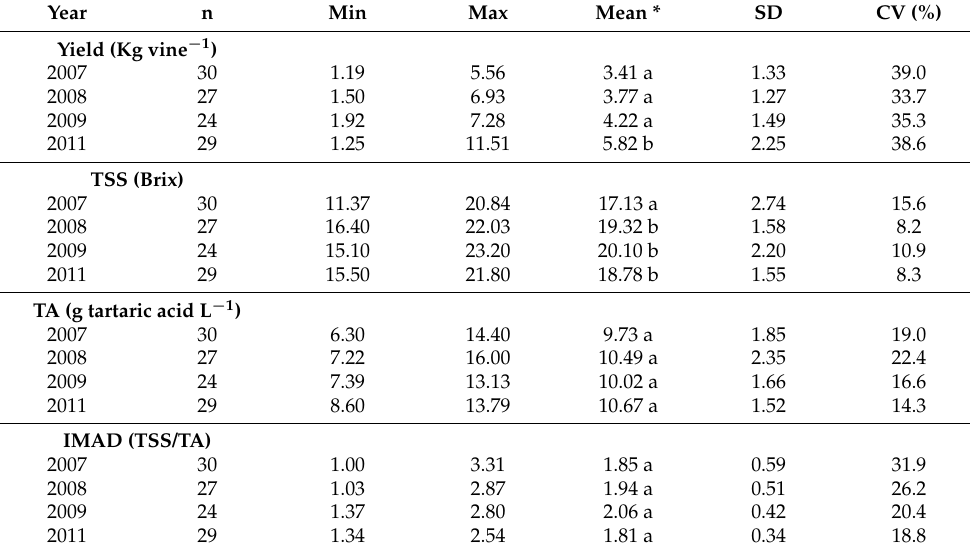
Table 4. Minimum (Min), maximum (Max) and mean (Mean) values, standard deviation (SD) and coefficient of variation (CV) observed on Yield, Total Soluble Solids (TSS), Total acidity (TA) and maturity index (IMAD) for the years of the study.